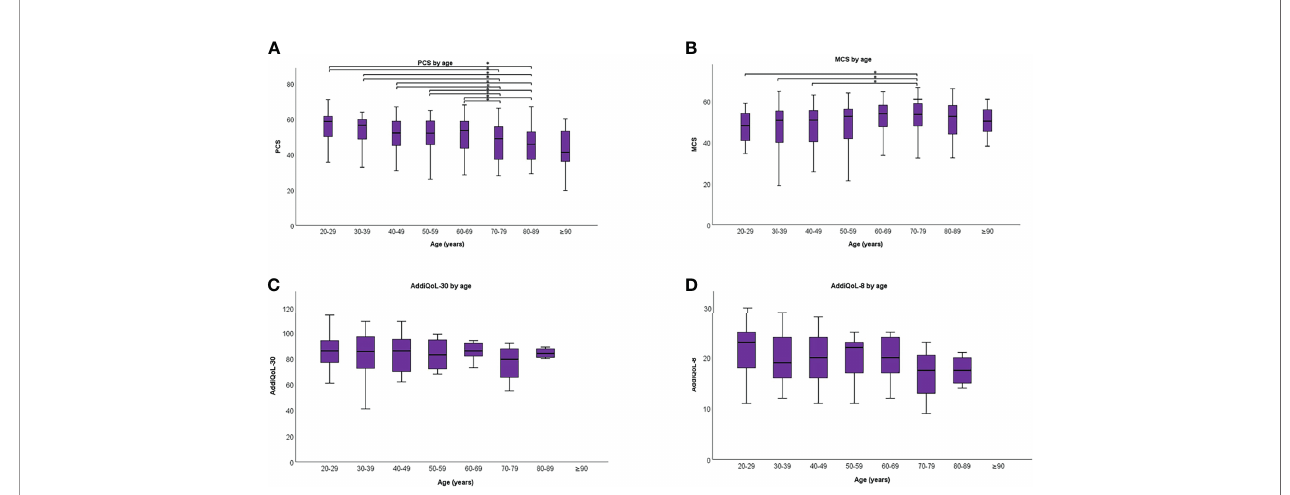
FIGURE 2 | Physical component summary (PCS) (A) , mental component summary (MCS) (B) , AddiQol-30 (C) , and AddiQoL-8 (D) scores in different age groups. The box marks the interquartile range, black horizontal line the median, and the whiskers the range. *p < 0.010.